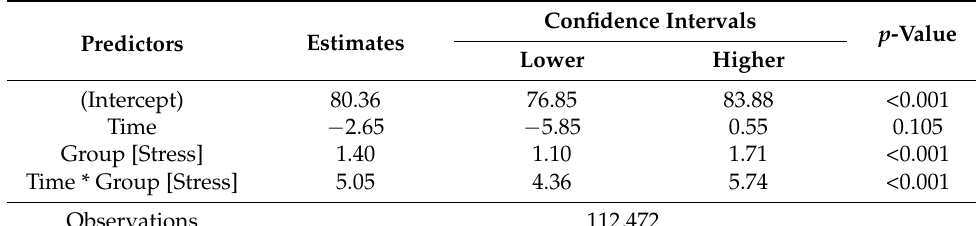
Table 4. Linear Mixed Model Results for Heart Rate Parameter.